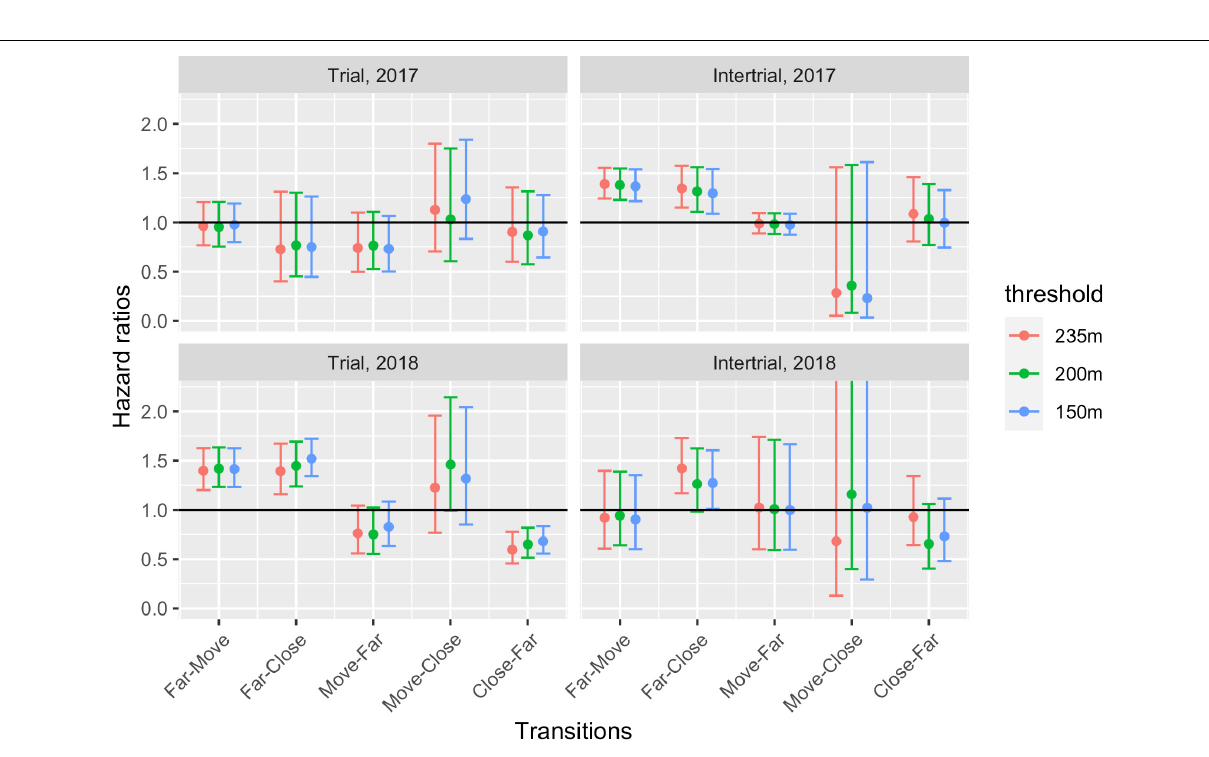
Frontiers in Marine Science |